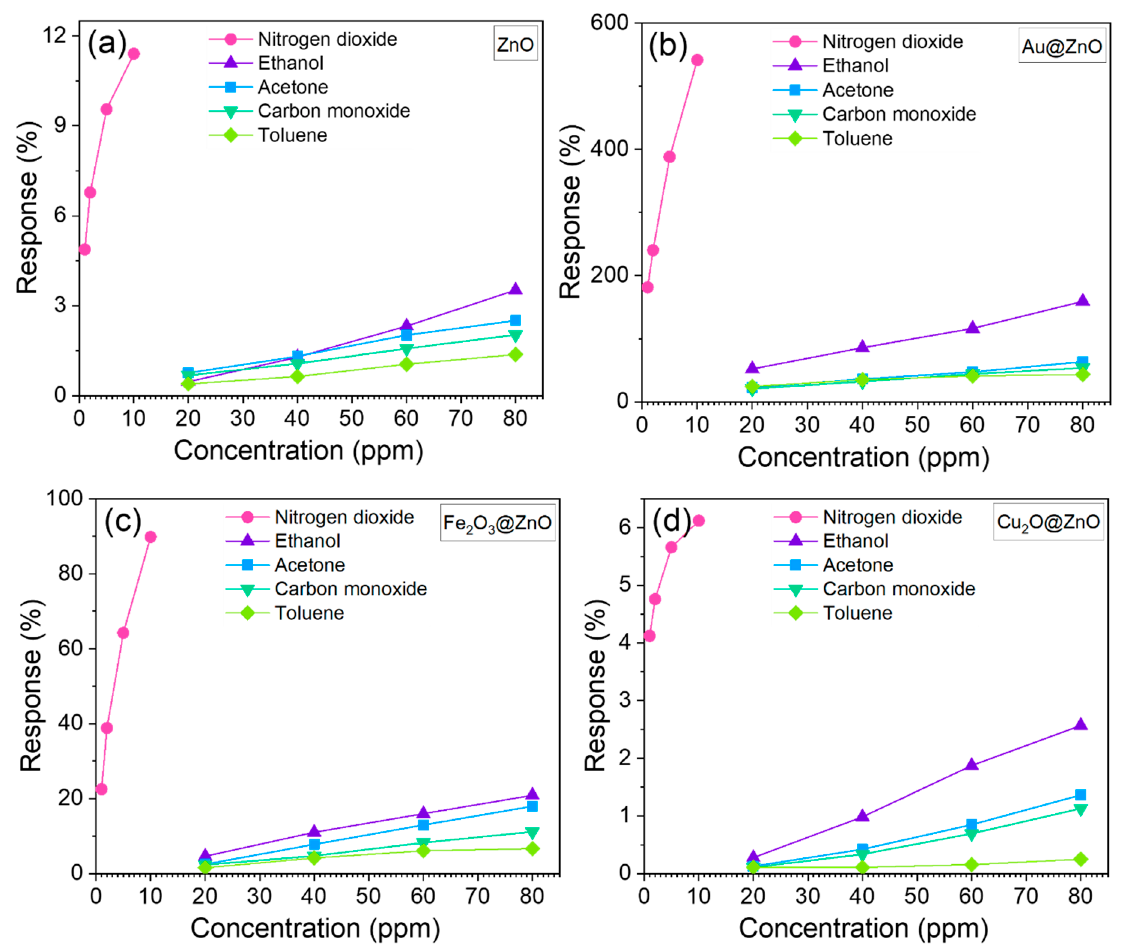
Figure 11. Response of the ( a ) ZnO ( b ) Au@ZnO, ( c ) Fe 2 O 3 @ZnO, and ( d ) Cu 2 O@ZnO sensors towards various concentra- tions of each target analyte.